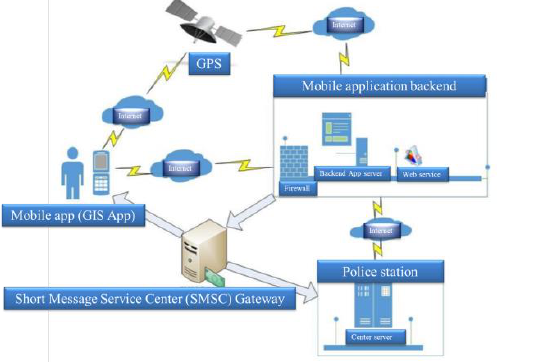
Figure 4: The general method of crime data collection by mobile-GIS